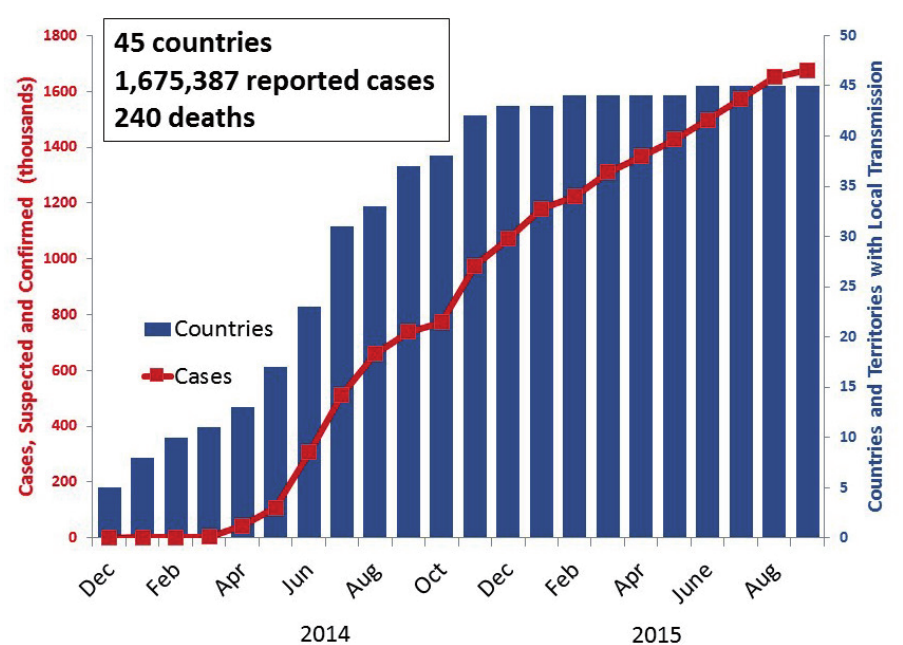
Figure 1. Number of countries in the Americas with local chikungunya transmission and number of cases reported to the Pan American Health Organization, by month, December 2013–September